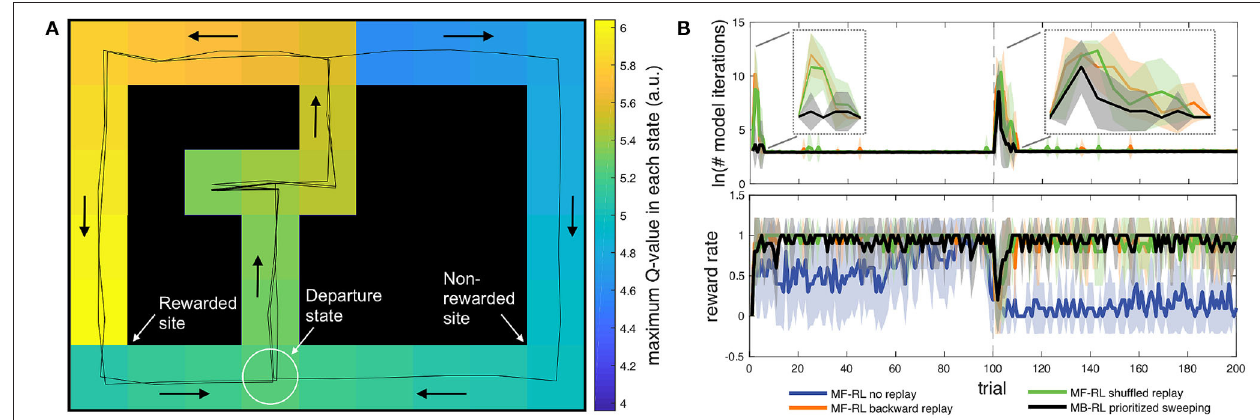
FIGURE 1 | (A) Discrete state-space simulations in the multiple T maze task (Cazé et al., 2018; Khamassi and Girard, 2020). The reward is on the left side for 100 trials and then shifted to the right side for the next 100 trials. In the present simulations, replay is only allowed in the departure state, before starting the next trial. Despite this constraint, the figure shows that after only 3 trials (2 correct / 1 error), the MF-RL algorithm with backward replay has already learned a full gradient of Q-values across the maze. (B) Comparison of the performance (reward rate) and computation time (Napierian logarithm of the number of iterations during replay phases) for 4 different algorithms. The thick lines represent the average, and the area around represents the mean square error. The figure illustrates that MF-RL without replay requires 60–70 trials to reach optimal performance and does not manage to adapt to the change in reward location within only 100 trials. All the other algorithms perform similarly in terms of reward rate: fast increase in performance; brief drop in performance after the change in reward location; fast re-increase of performance afterward. These algorithms mainly differ in the required duration of the replay phases: MF-RL with random replay and MF-RL with backward replay both show a strong peak in the number of replay iterations after the change in goal location. The state-based version of MB-RL prioritized sweeping shows a smaller peak.